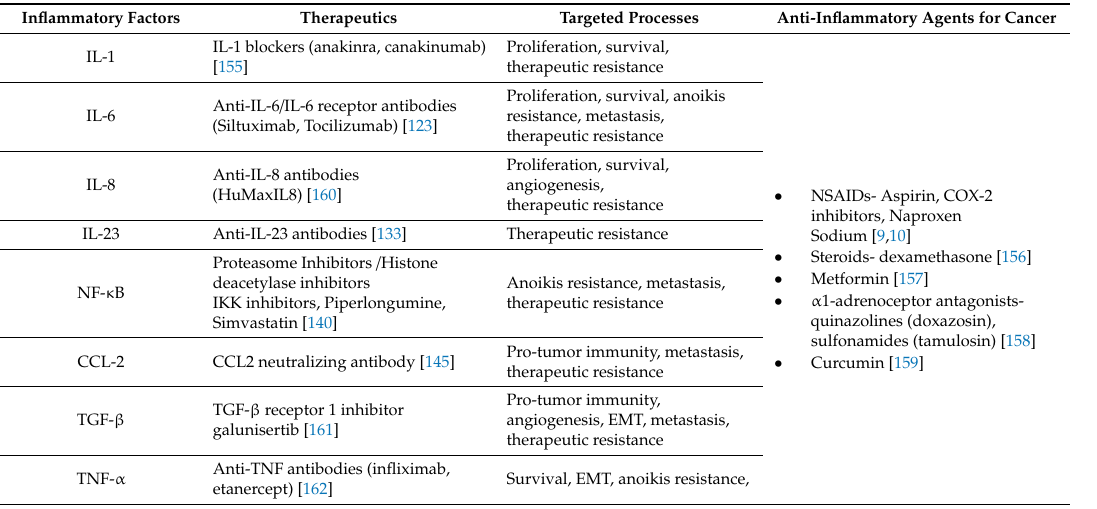
Table 1. Inflammation as a Developmental Platform for Predictive Signatures and Targeted Therapeutics in Advanced Prostate